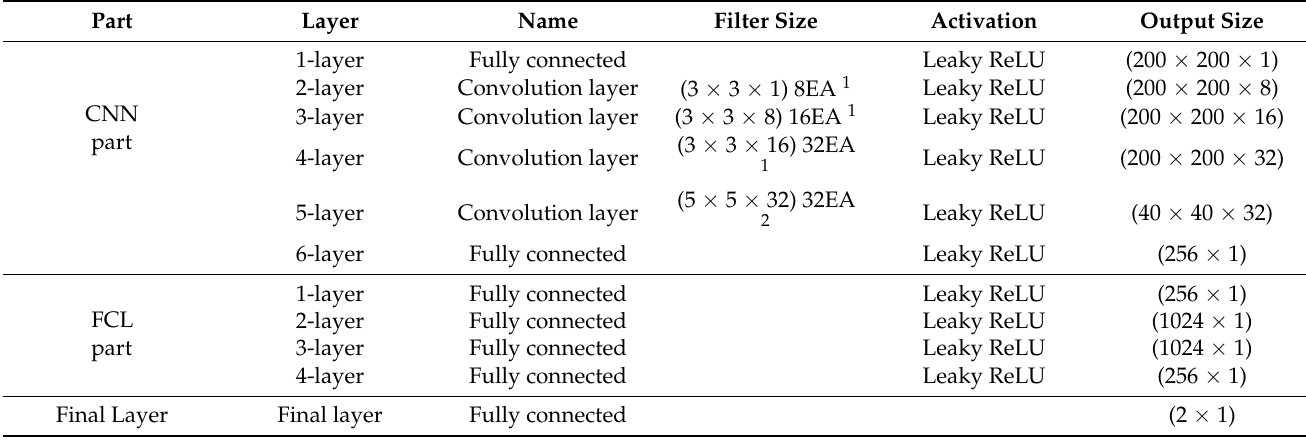
Table A2. Details of neural